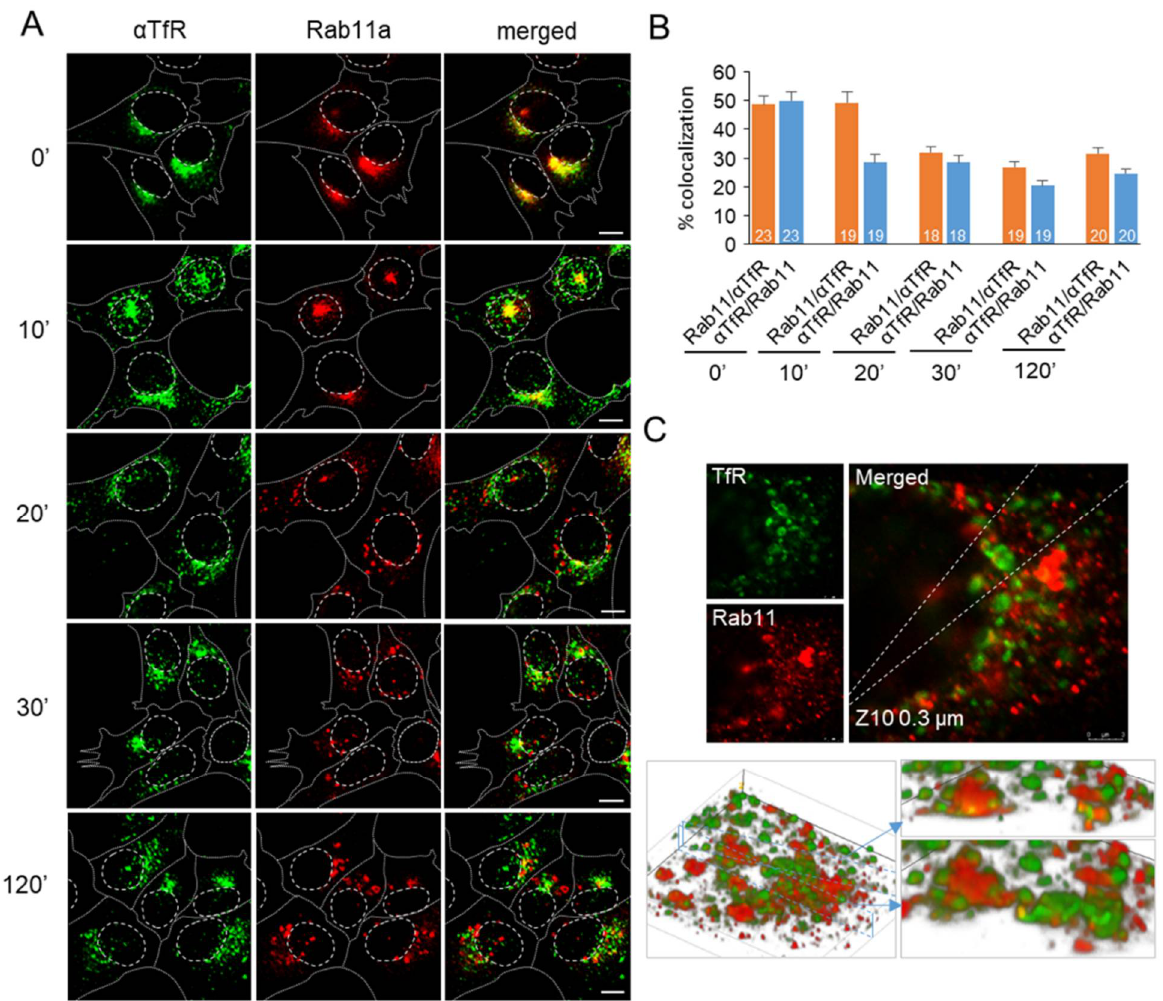
Figure 5. IN1 treatment splits recycling cargo from Rab11a-positive membrane domains. Cell surface TfRs of Balb 3T3 cells were labeled with anti-TfR mAb (R17) at 4 °C, labeled TfRs were internalized at 37 °C for 60 min to achieve the steady-state cycling, and cells were treated with 3 μM IN1. ( A ) Representative images ( n = 15–20) of mAb-labeled TfRs and Rab11a before (0′) and 10′–120′ after treatment with IN1. Cell borders are indicated by fine dotted lines and cell nuclei by fine dashed lines. Bars, 10 µ m. ( B ) The 3D colocalization of Rab11a and mAb-labeled TfRs based on the M1/M2 coefficients of pixel overlap measured across the Costes-algorithm thresholded z-stacks of confocal images. Data represent mean ± SEM per cell (number of cells indicated in bars). ( C ) Example of 3D reconstruction of Rab11a- and mAb/TfR-labeled endosomes after 120 min treatment with 3 µ M IN1. The top panel shows confocal images (z10 of 0.3 µ m sections), and the bottom panel shows 3D reconstruction of the entire z-stack (21 slices) using the Volume Viewer plugin. The image shown on the left presents the 3D view of the entire stack, and the images on the right show the view across the vertical slice through the stack as indicated by dashed